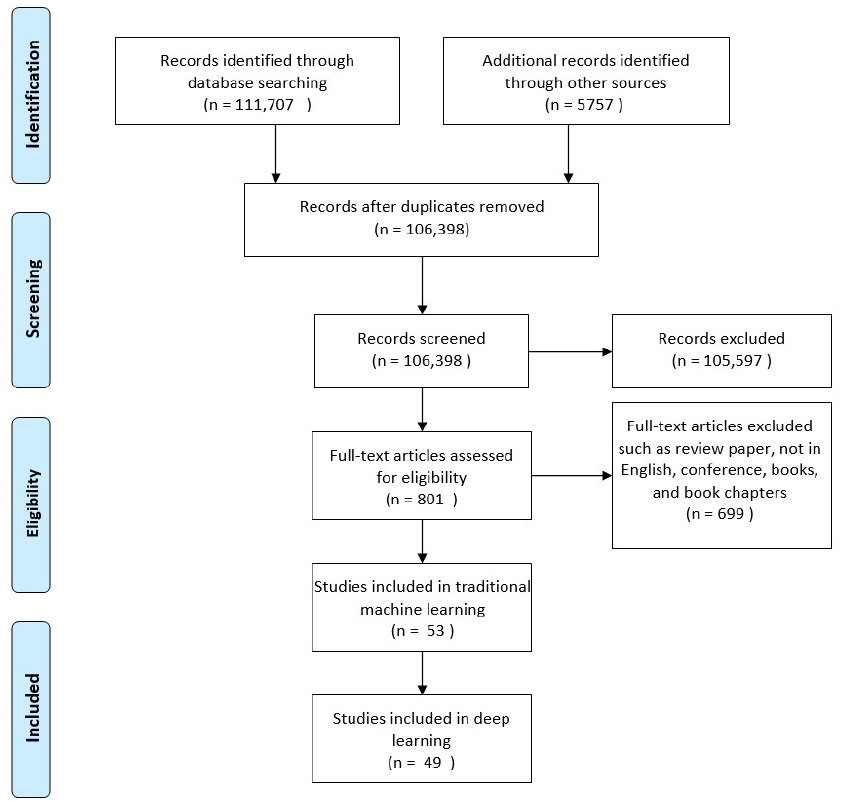
Figure 2. Study selection using PRISMA flow